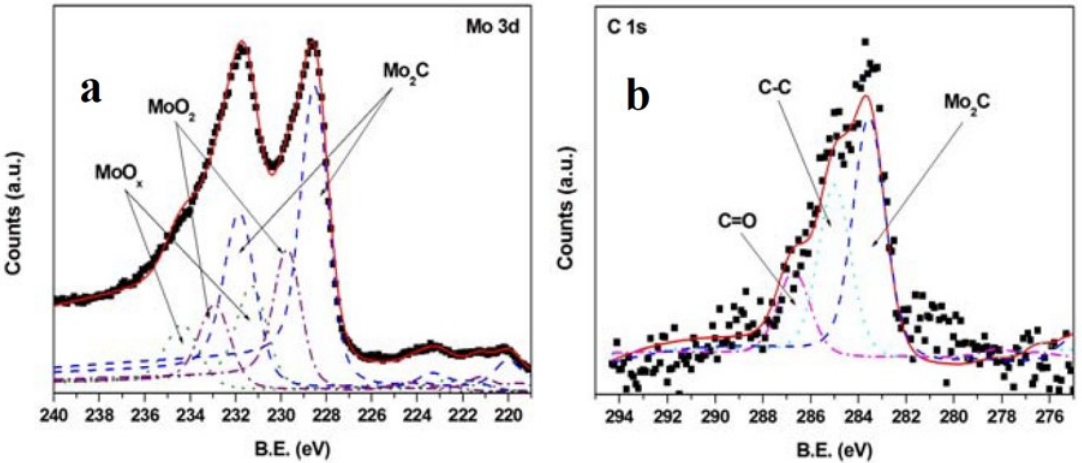
Figure 8. XPS spectra of a Mo 2 C film deposited at 600 °C: ( a ) Mo 3d region, ( b ) C 1s region. Reprinted with permission from [111], copyright 2012 Wiley and Sons.